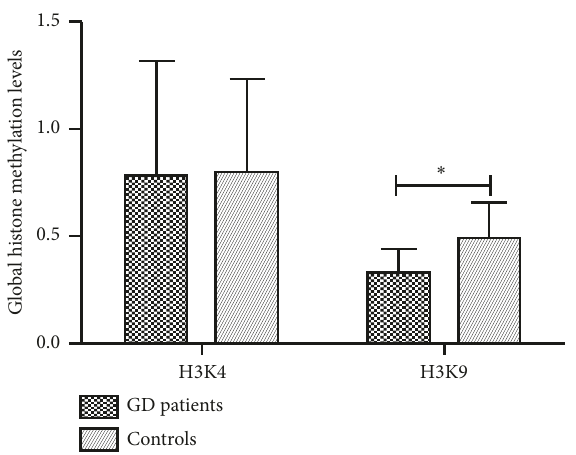
Figure 3: Relative mRNA levels of HDMs in PBMCs of patients with GD and healthy controls. Results represent mean ± SD expression levels normalized to 𝛽 -actin. JHDM2A and JMJD2A were significantly increased in GD patients ( ∗∗ P < 0.001; ∗ P=0.007).